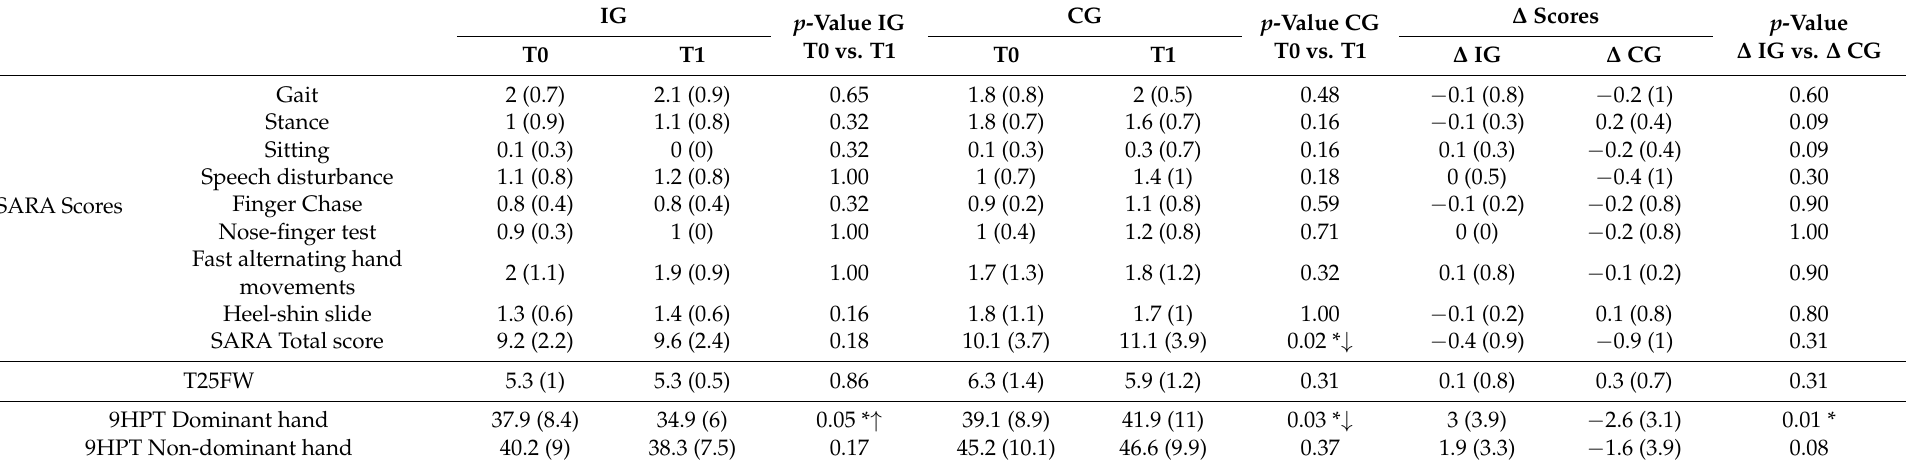
Table 3. Descriptive statistics and statistical analysis of outcome measures scores for IC and CG at T0 and T1 and occurred scores variation ( ∆ ). “IG” (T0 and T1), “CG” (T0 and T1), and “ ∆ Scores” ( ∆ IG and ∆ CG) columns report the average score and standard deviation (in parenthesis) for each outcome measure. “ p -value IG T0 vs. T1” and “ p -value CG T0 vs. T1” columns report the results obtained from the Wilcoxon Signed-Rank test analyzing the scores difference between T0 and T1